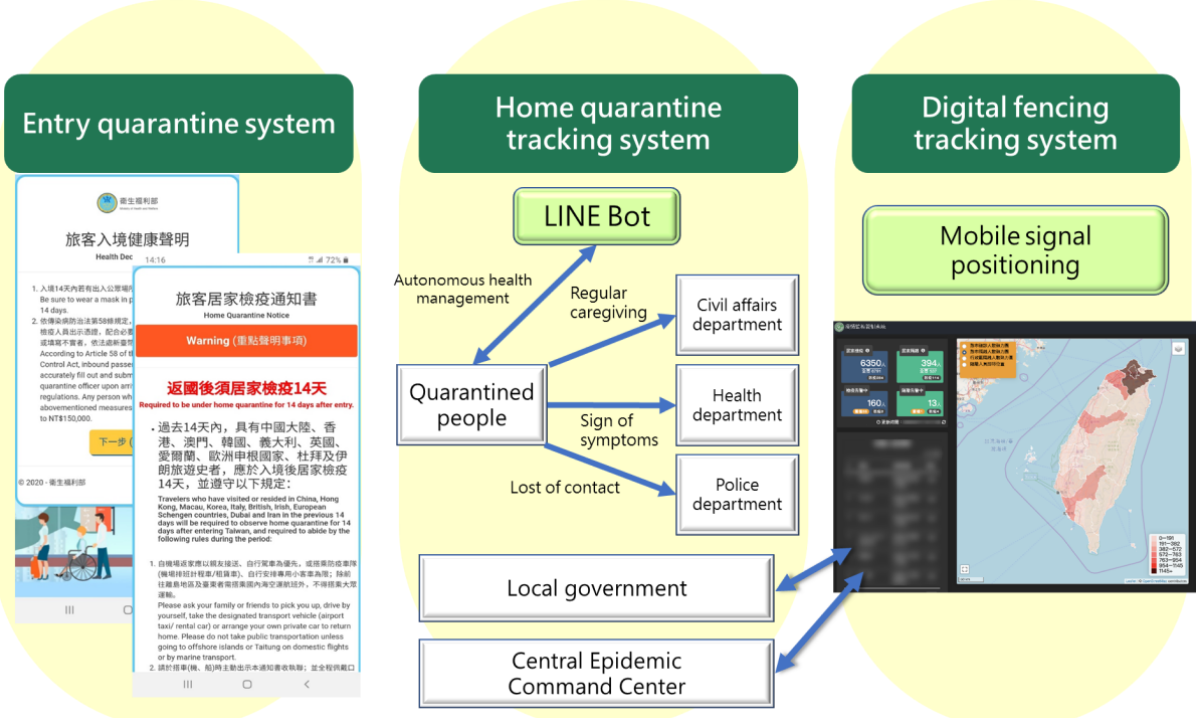
Figure 3. Diagrammatic representation of the border control and home quarantine